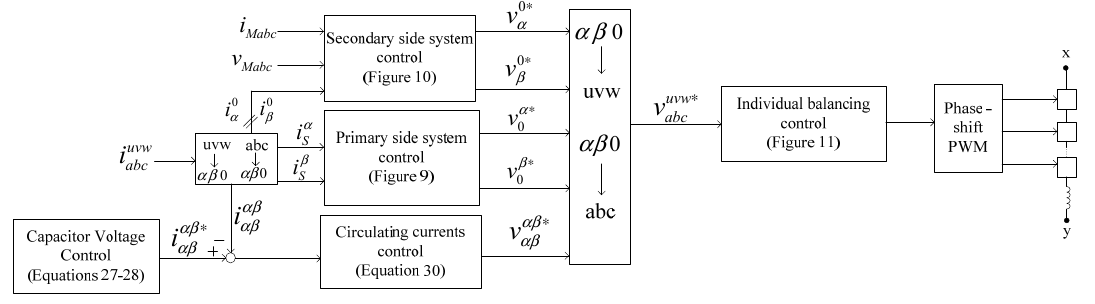
Figure 7. Overview of the control strategy.